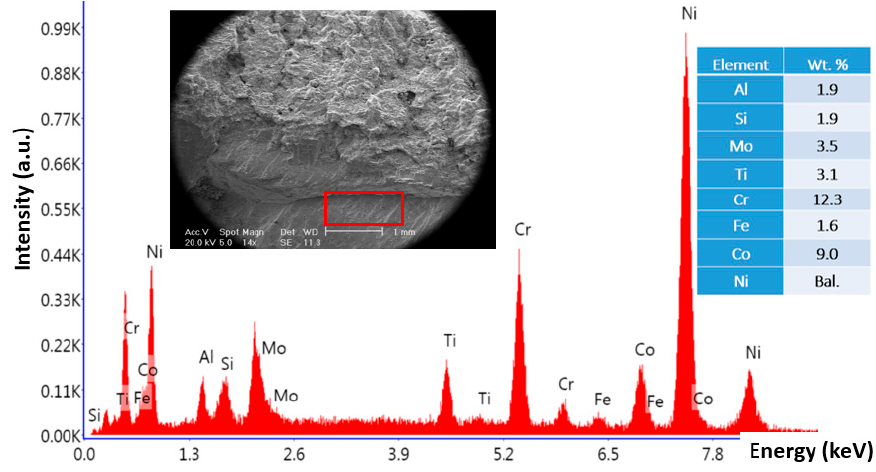
Figure 5. EDS analysis of the area with beach marks in the failed blade, broken from the root.